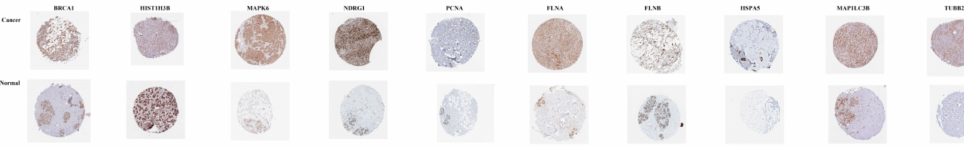
Figure 21. Validation of the hub genes using the Human Protein Atlas (HPA)